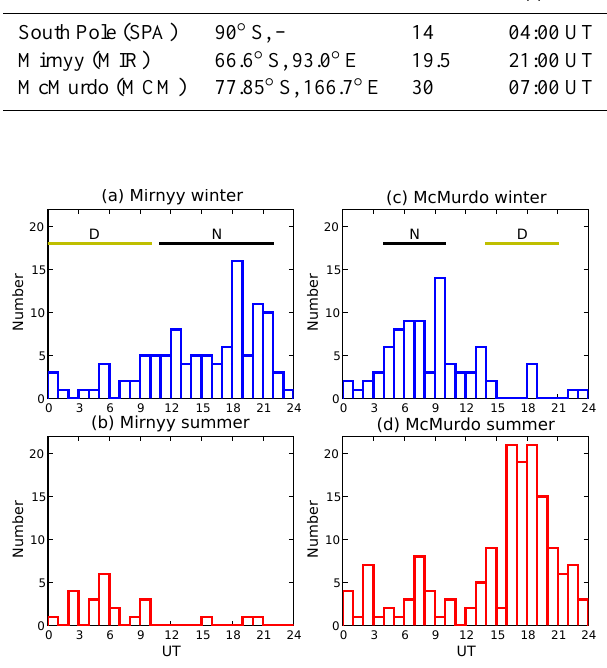
Fig. 5. Diurnal event occurrence at very high latitudes: (a) Mirnyy winter; (b) Mirnyy summer; (c) McMurdo winter; (d) McMurdo summer. The day and night periods of event occurrence were de- fined by inspection of the plots.